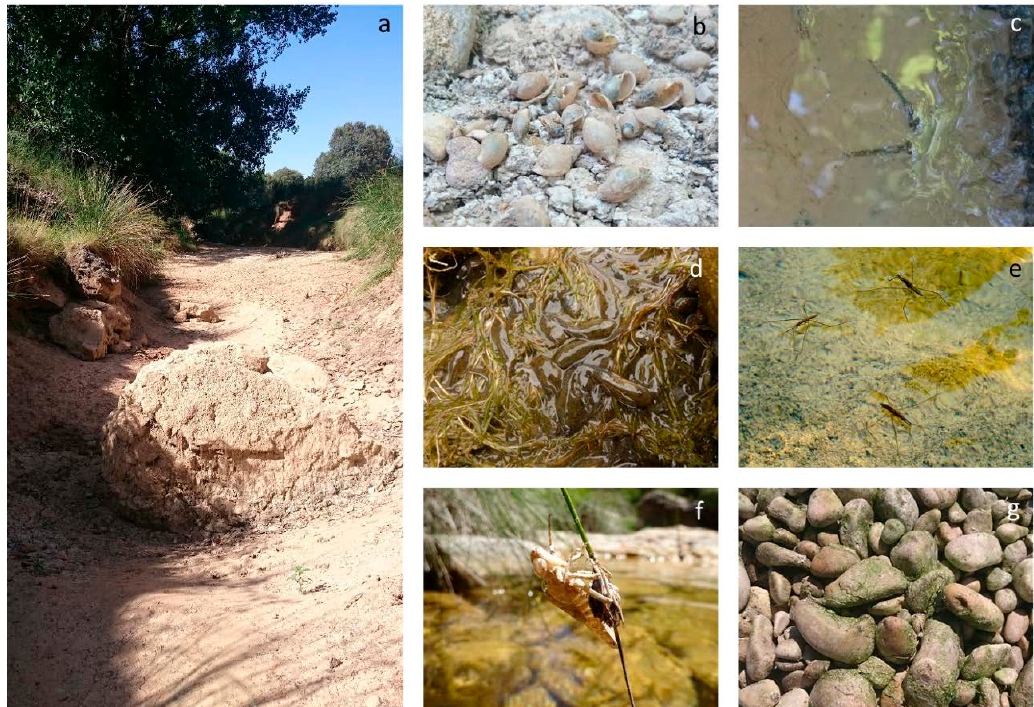
Figure 5. A dry isolated pool in the Guadazaón River (Júcar river basin, Spain) ( a ) and effects on the aquatic organisms. Some of them, such as molluscs ( b ), aquatic insects ( c ), or amphibians ( d ) without life cycles synchronized with drying are trapped in dry river beds and eventually die. Others, such as many heteropterans ( e ), are able to fly away and look for other aquatic refuges. Several species also have their life cycles synchronized and emerge before the IP dries up ( f ) (a larvae of Odonata) or stay in dry river beds as resistant forms until flow resumption ( g ) (benthic algae) [115] . Photo credits: N. Cid ( a – c , f , g ) and N. Bonada ( d , e ).